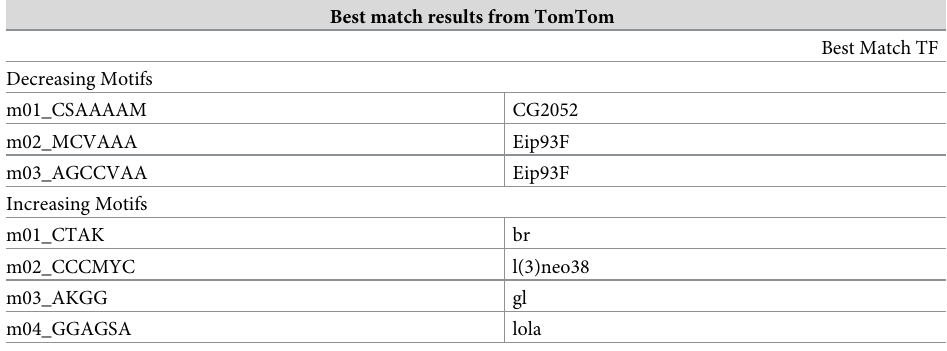
Table 2. Summary of all TomTom matches for denovo motifs discovered in E93 responsive ChIP